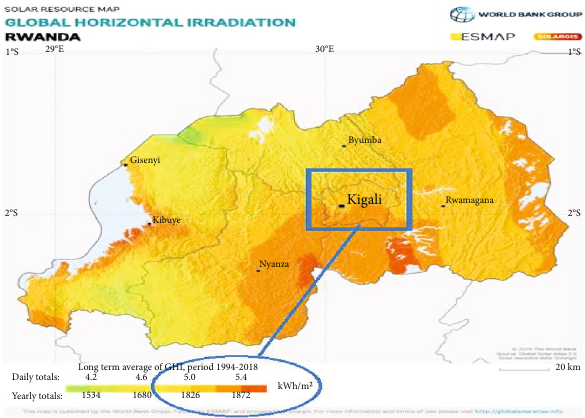
Figure 1: Kigali horizontal radiation